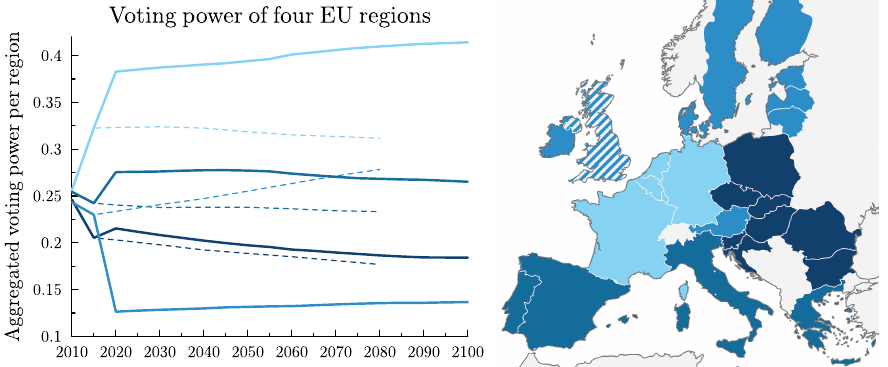
Figure 2. Power index projections for four regions color-coded on the map. Dotted/solid lines show the 2014 pre-Brexit status quo/Brexit forecasts,